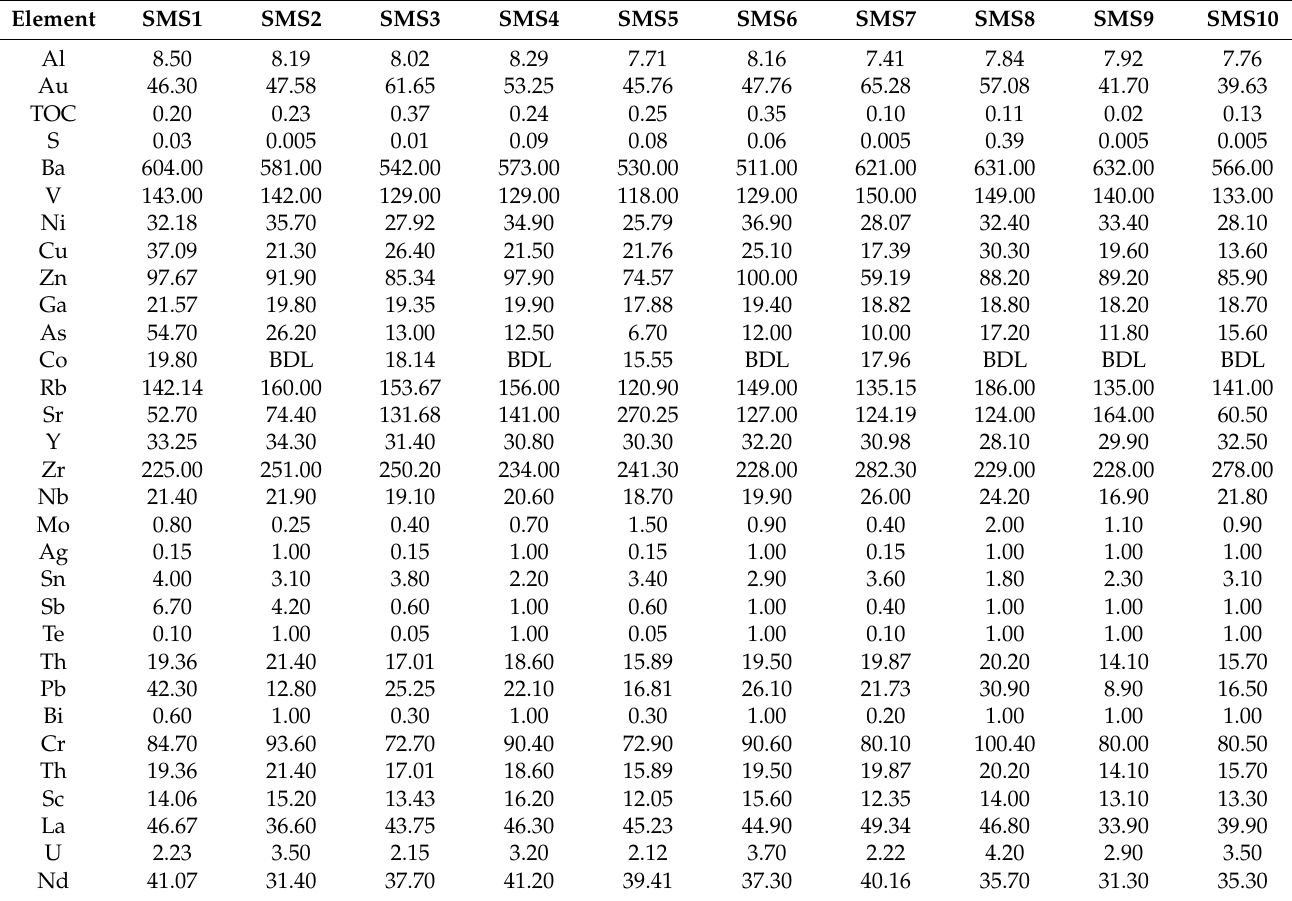
Table 1. Trace element, aluminum, and total organic carbon contents in black mudstones from the Singa Formation, Langkawi Malaysia. This table comprises ten samples (SM1–10) that were analyzed. Unit: Al (wt.%); TOC (wt.%); S (wt.%); Au (ppb); other trace elements (ppm); BDL = below detection limit.